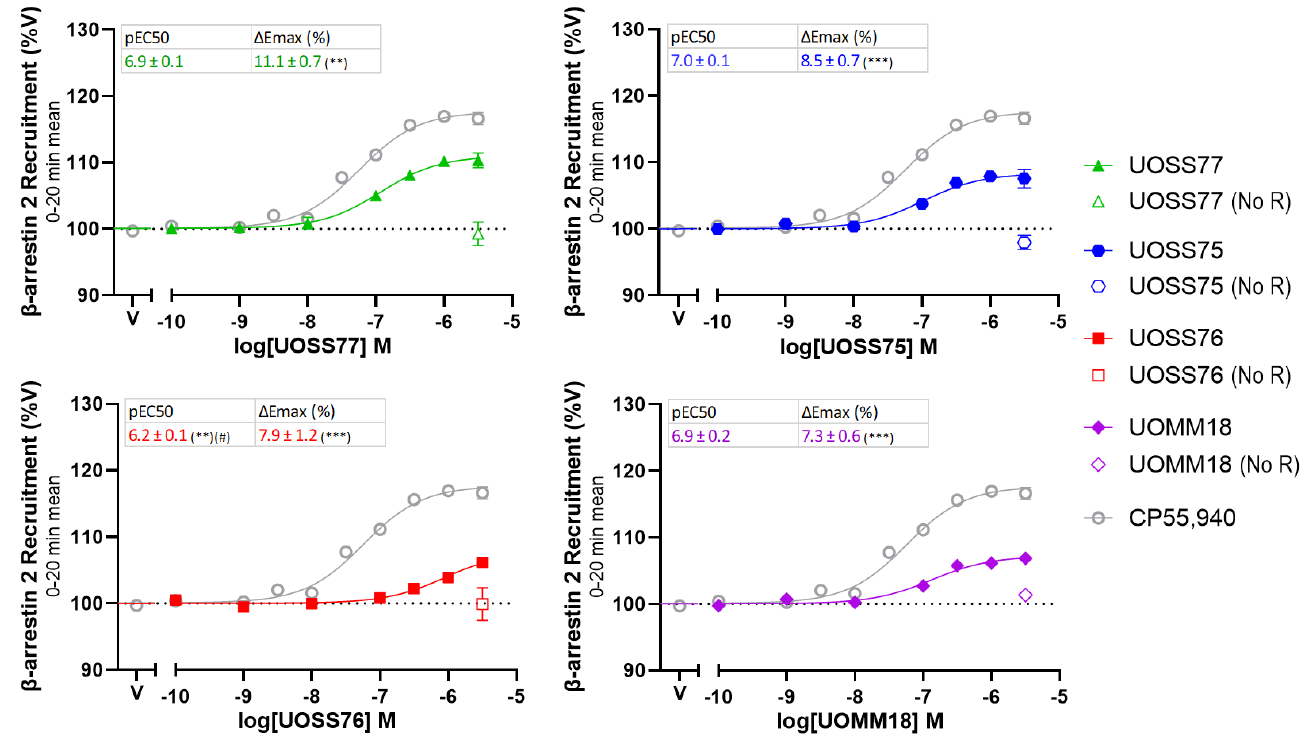
Figure 4. β-arrestin-2 plasma membrane translocation induced by varying concentrations of com- pounds of interest, in cells transfected with human CB2 or control plasmid (“No R”). Biosensor meas- urements over a 20 min drug treatment were averaged, then normalised to vehicle-treated (V; 100%). pEC 50 and ΔE max (% increase above V) are displayed in boxes for test compounds. CP55,940 has pEC 50 7.2 ± 0.1 and ∆E max 17.6% ± 0.8%. Plotted and parameter data are mean ± SEM from three independent experiments. Asterisks and hashes represent a significant difference to the parameters of CP55,940 and UOSS77, respectively. #, ** and *** represent p < 0.05, 0.01 and 0.001, respectively.